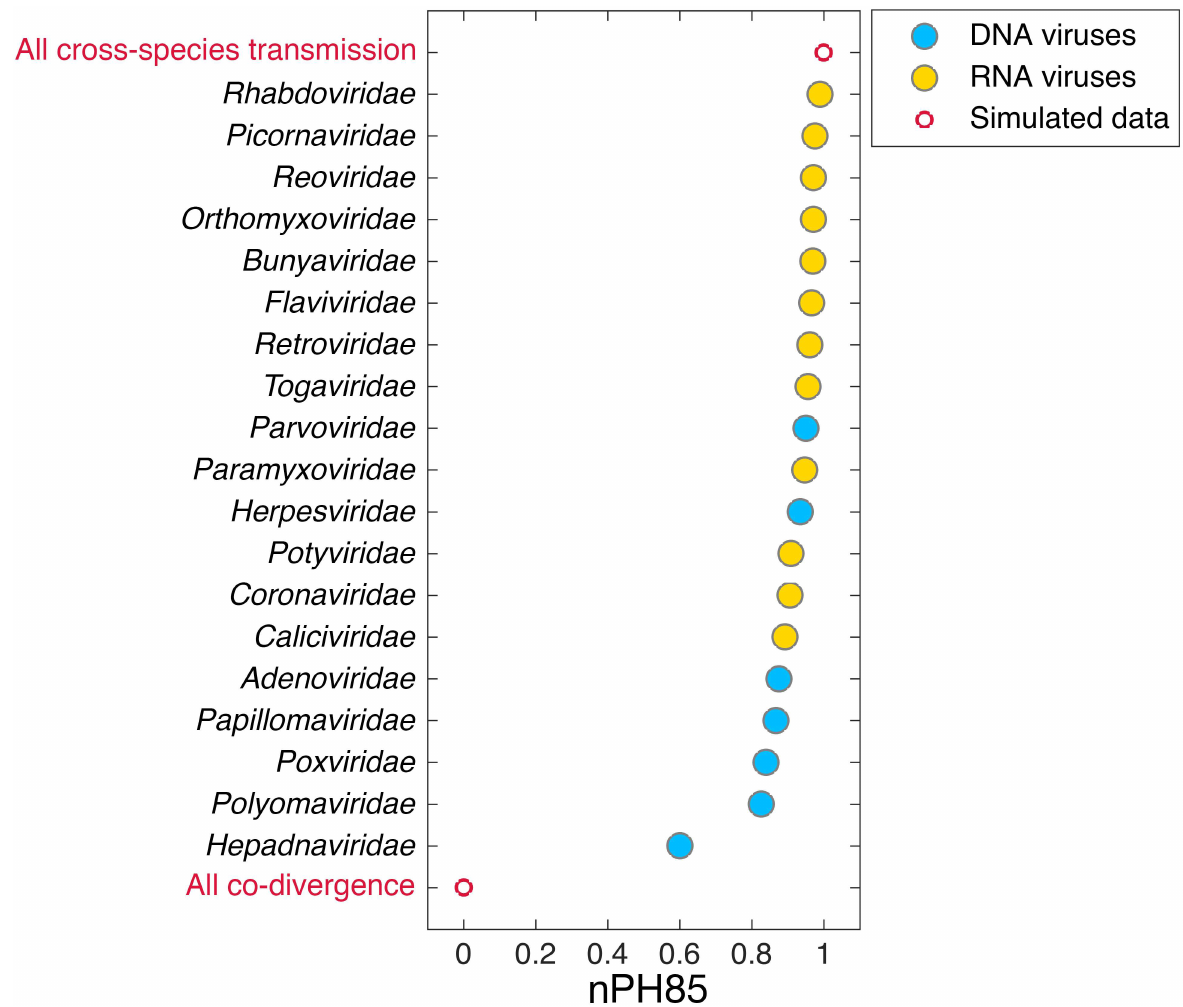
Fig 2. Overall normalized topological distance between two unrooted phylogenetic trees for each virus family by normalizing the Penny and Hendy [14] metric (i.e. nPH85). A range of DNA (blue) and RNA (yellow) virus families are shown. If nPH85 = 0, it is indicativeof virus-host co-divergence, whilenPH85 = 1 suggests frequentcross-speciestransmission (red). For ease of interpretation virus families are rankedby descending frequency of cross-species transmission.